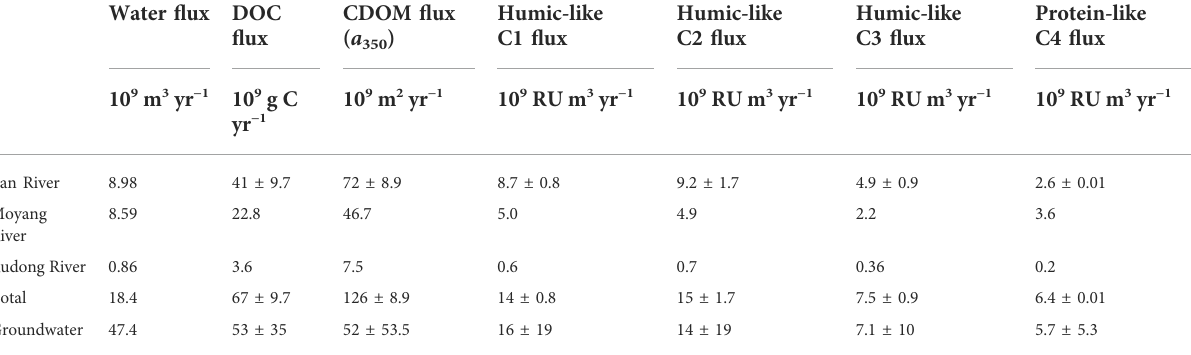
TABLE 2 The export fl uxes of water, DOC, CDOM, and FDOM via fresh groundwater discharge and river runoff in western Guangdong.